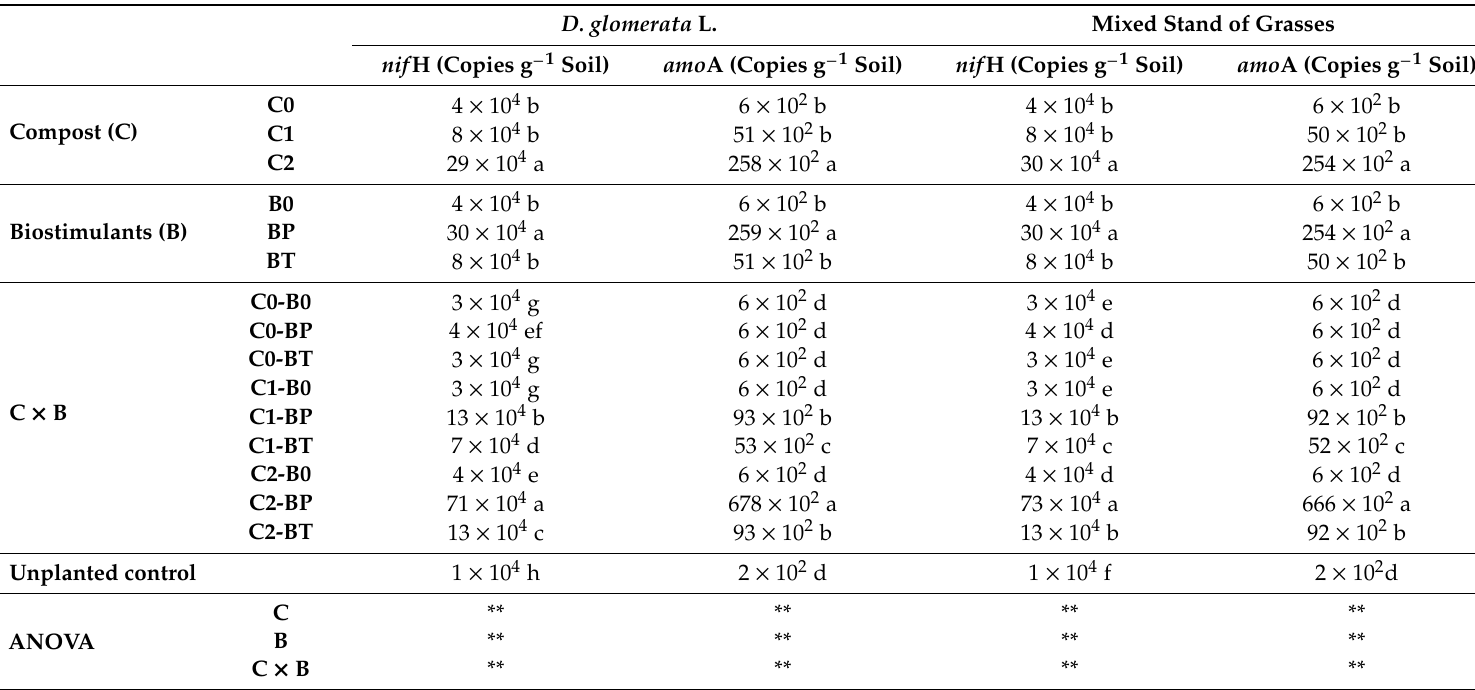
Table 3. Quantification of nif H gene and amo A gene abundance in the rhizosphere of D. glomerata L. and in a mixed stand of F. arundinacea Shreb. , L. perenne L. and P. pratensis L. C0 = no compost, C1 = 0.7%, C2 = 1.4%; B0 = no biostimulants, BP = Panoramix, BT = Trianum-P; Unplanted control = non-planted and untreated soil. Mean values within columns and factor with the same letter do not di ff er according to the LSD test ( p < 0.05). * p < 0.05; ** p < 0.01; n.s., not